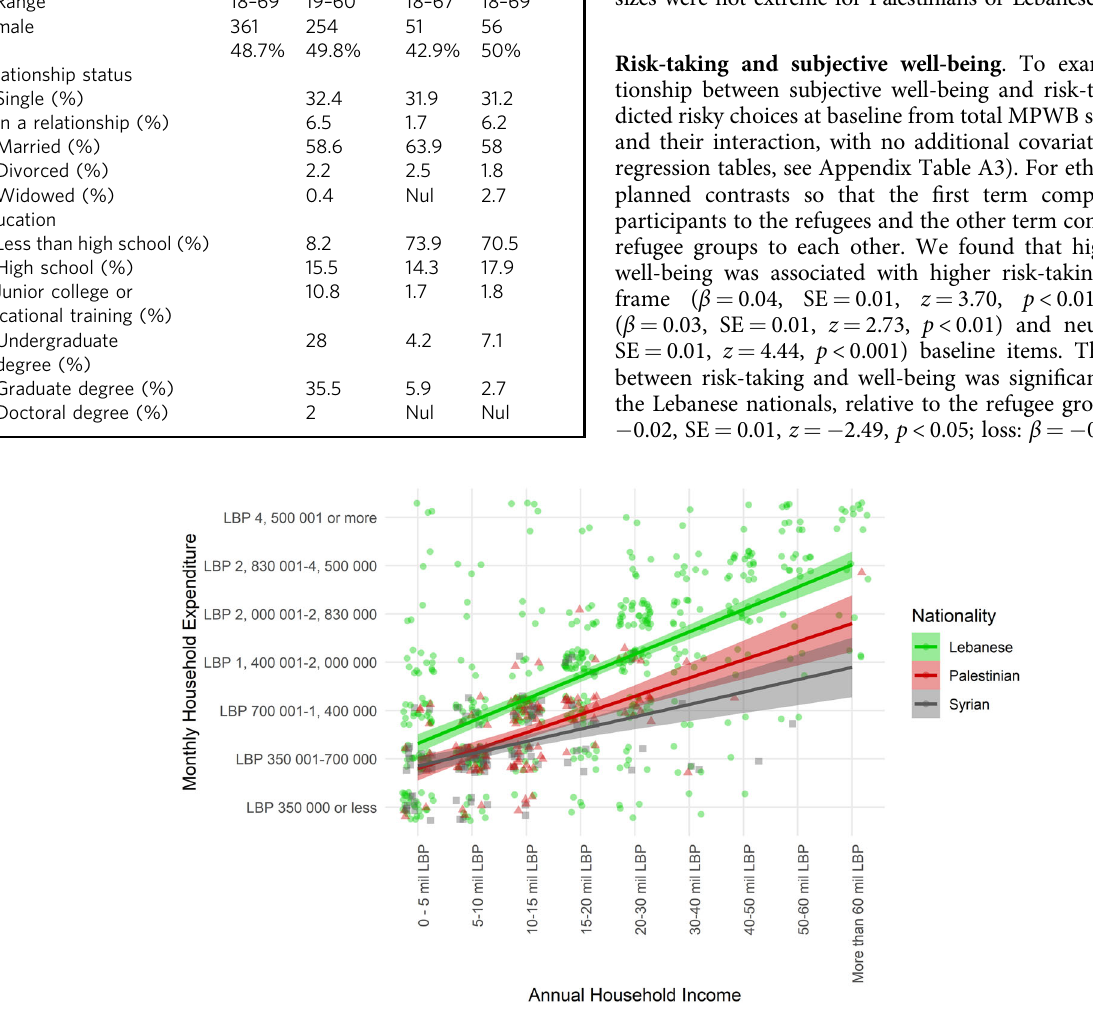
Fig. 1 Household income and expenditure. Lebanese participants have signi fi cantly higher incomes and monthly expenditure averages than Syrian and Palestinian participants across all brackets in the sample, indicated by the green line being entirely parallel to the red and black